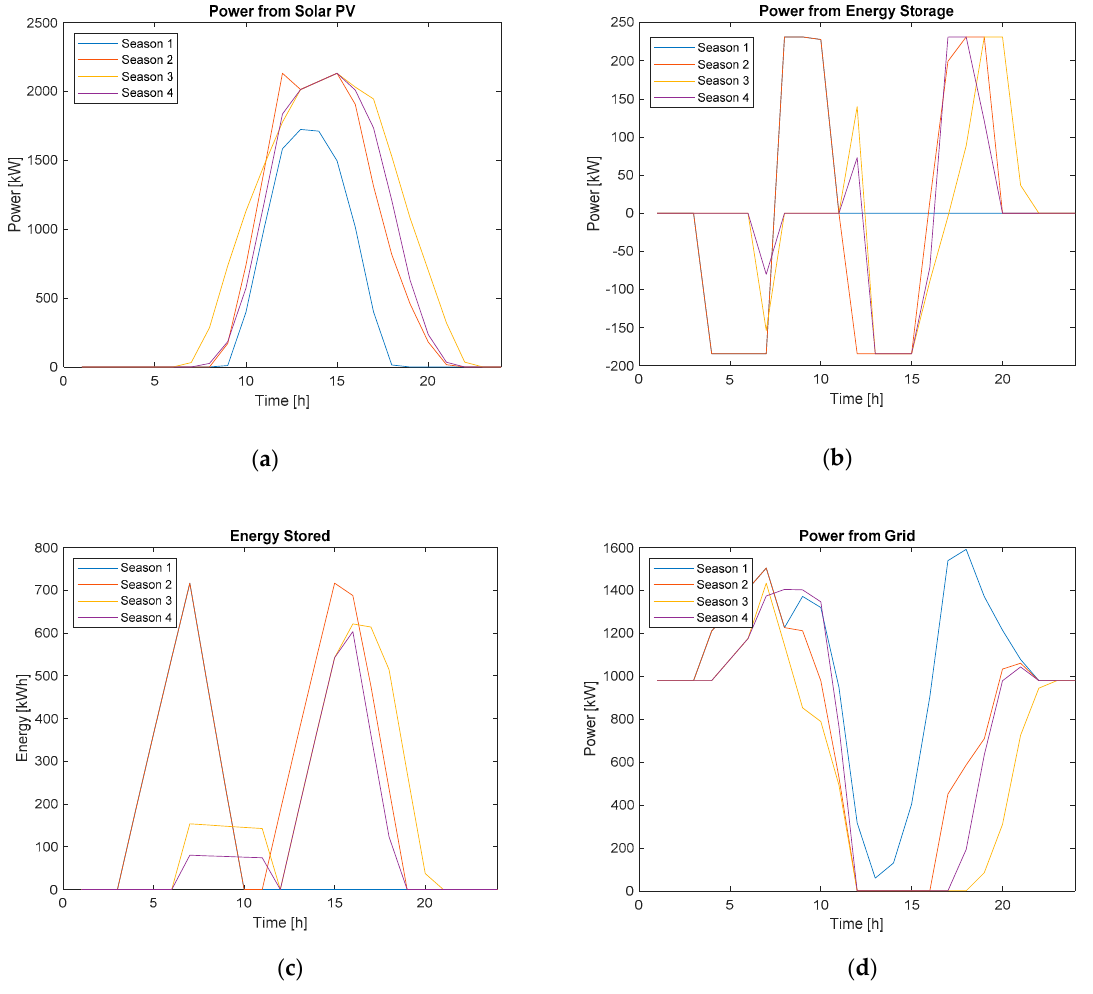
Figure 5. ( a ) Solar PV power from a 4903.28 kW system; ( b ) power from energy storage for solar PV, energy storage, and grid power case; ( c ) energy stored for solar PV, energy storage, and grid power case; ( d ) power from the grid for solar PV, energy storage, and grid power case.